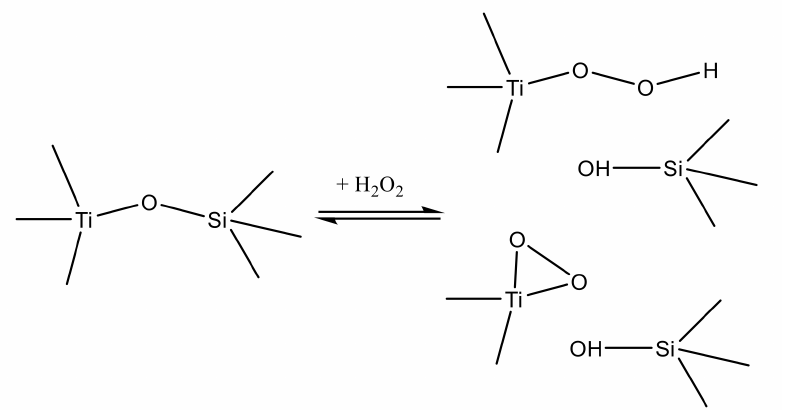
Scheme 4. Formation of the Ti-(hydro)peroxo site. Adapted from ref. [86], used with permission. Copyright 2010 Elsevier.